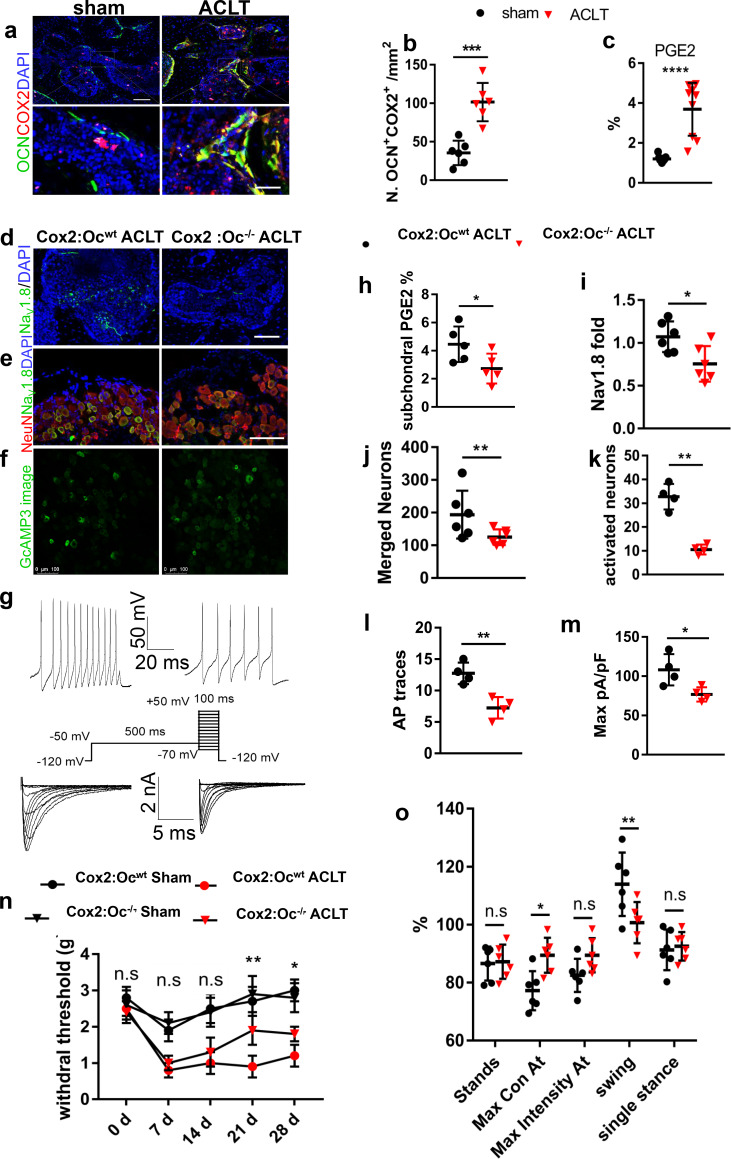
Decreased NaV1.8 expression and ameliorated OA progression in Cox2:OCN cKO ACLT mice.(a,b) Representative pictures (a) and statistical analysis (b) of OCN and Cox2 co-stained cells of murine tibial subchondral bone after sham or ACLT surgery and 1 m. Scale bars, 50 μm (left) and 10 μm (right), n = 6 per group. (c) Relative concentration of subchondral PGE2 compared with total protein concentration before and after ACLT. (e–g) Nav1.8 (green) immunostaining in subchondral bone (d), NeuN (red), NaV1.8 (green) and DAPI (blue) co-immunostaining in ipsilateral L4 DRG (e), Activated neurons in ipsilateral L4 DRG using in vivo Pirt-GCaMP3 imaging (f) and AP traces and NaV currents (g) after sham or ACLT surgery at 1 m. Scale bars, 20 μm (h), 100 μm (e, f). (h–o) Statistical analysis of subchondral PGE2 concentration (h), NaV1.8 immunofluorescence signal in subchondral bone (i), number of NeuN, Nav1.8 co-immunostained neurons in ipsilateral L4 DRG (j), number of activated neurons in ipsilateral L4 DRG using in vivo Pirt-GCaMP3 imaging (k), AP traces (l) and NaV currents (m), Catwalk gait analysis (n) and left HPWT (o) after sham or ACLT surgery. n = 6 per group, *p<0.05, **p<0.01, ***p<0.001, ****p<0.0001 compared with the sham-operated group at different time points. Statistical significance was determined by multifactorial ANOVA WITH BONFERRONI POST HOC TEST (h) or unpaired Student’s t test (b, c, h–m and o), and all data are shown as scattered plots with means ± standard deviations.Figure 2—source data 1.Raw data of OCN Cox2 costaining, subchondral PGE2, GcAMP3 imaging, NeuN Nav1.8 merged neurons, electrophysiological recordings, Von Frey tests and catwalk analysis.